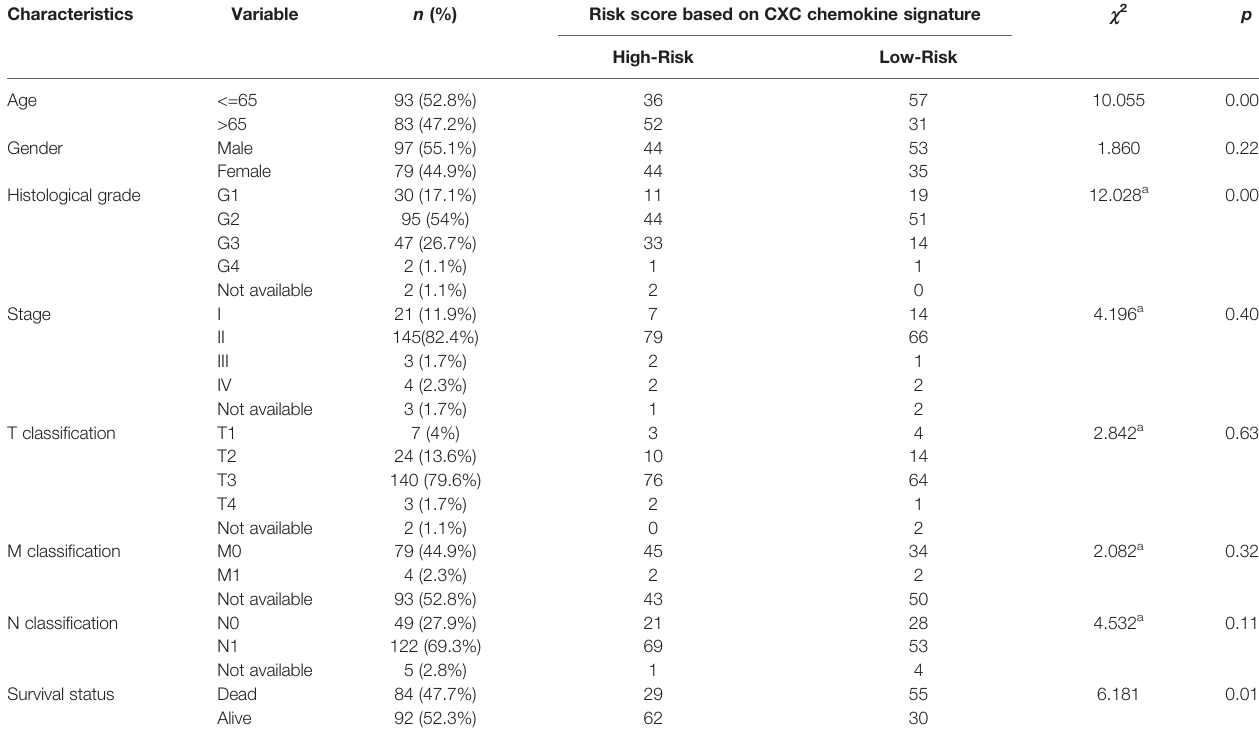
TABLE 7 | Clinicopathological features of the PAAD patients in TCGA cohort and the relationship between clinicopathological features and CXC chemokine signature (TCGA and SurvExpress).